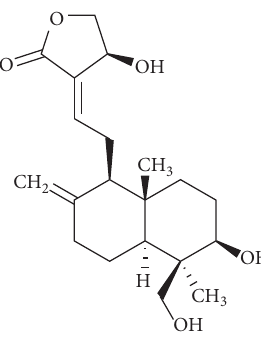
Figure 1: Chemical structure of